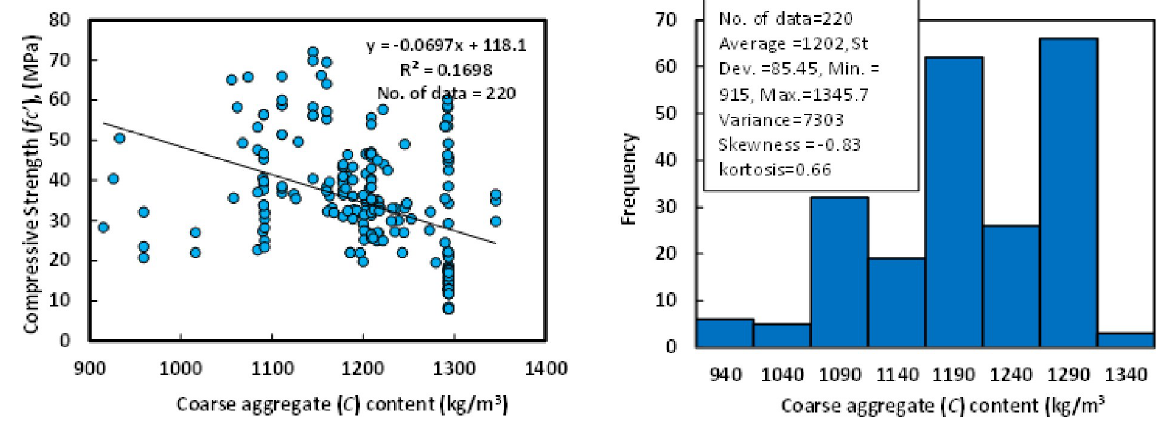
Fig 8. Relationship and a histogram of compression strength versus coarse aggregate content of GGBS/FA-GPC.